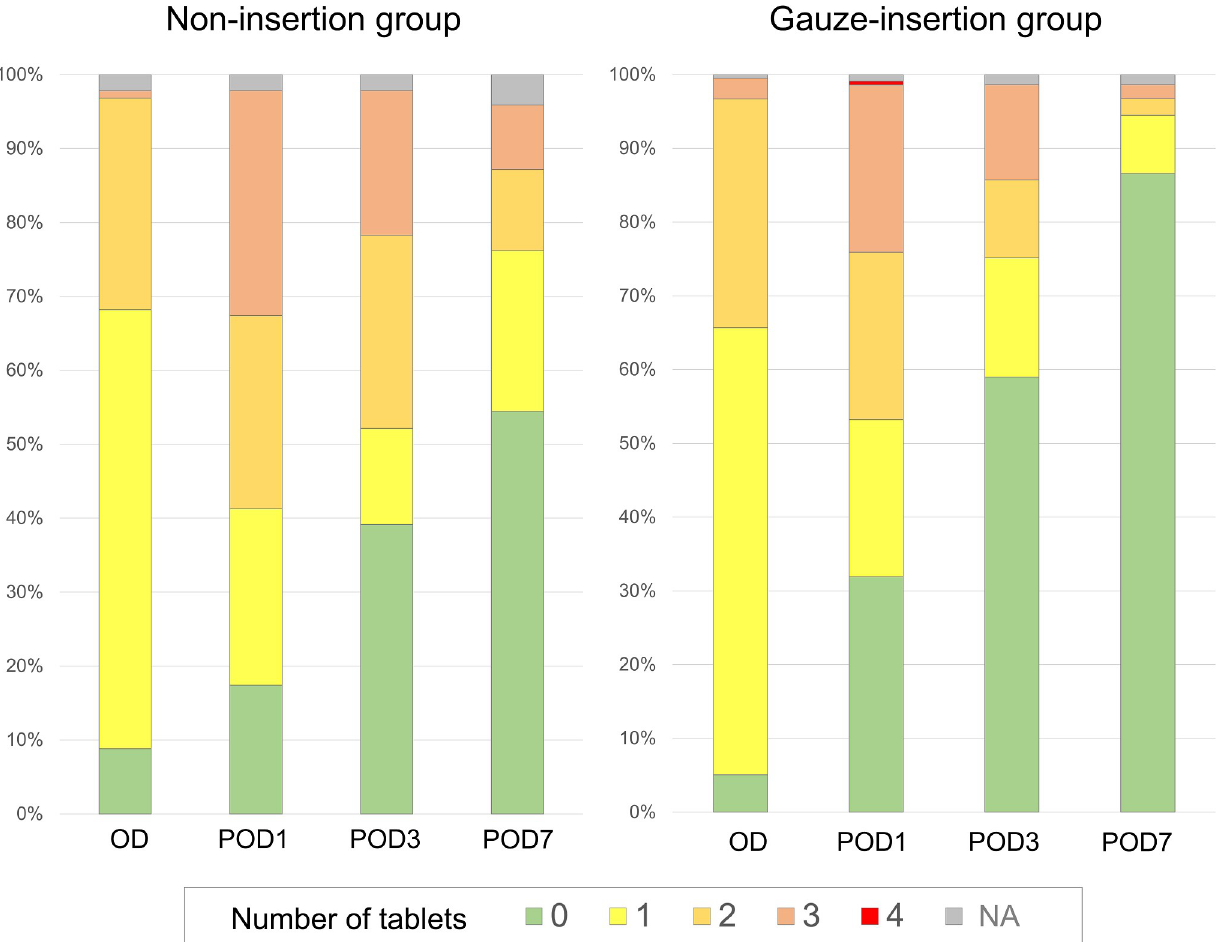
Fig 3. Number of oral analgesic tablets taken by each group. Patients reported the number of loxoprofen sodium oral analgesic tablets (60mg/tablet) they had taken on the operative day, on the first postoperative day (POD1), on POD3, and on the day of suture removal (POD7). Abbreviations: OD, operative day; POD1, etc., postoperative day 1,